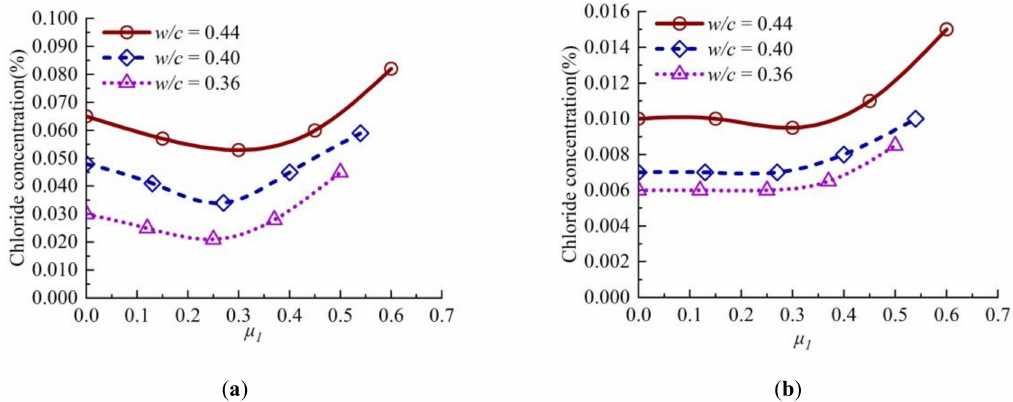
Figure 4. Variation curve of chloride concentration of concrete with stress level µ 1 at di ff erent depths: ( a ) 12.5 mm; ( b ) 22.5